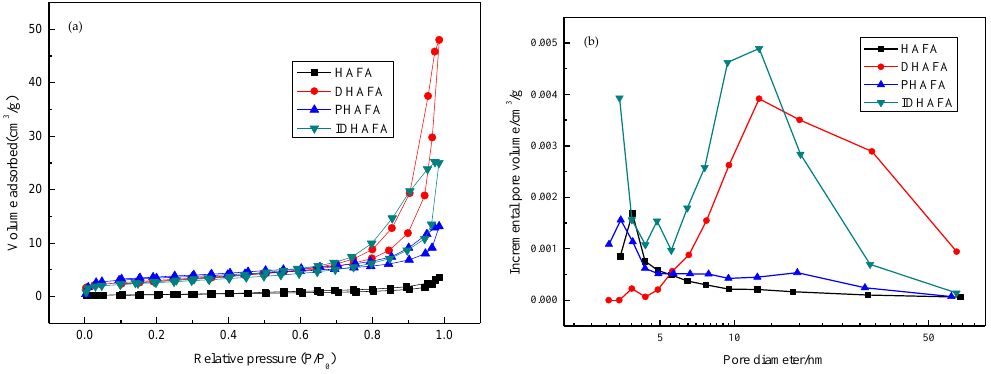
Figure 10. Nitrogen adsorption – desorption isotherms and pore size distribution of HAFA, DHAFA, PHAFA, and IDHAFA. ( a ) Nitrogen adsorption – desorption isotherms, ( b ) Pore size distribution.